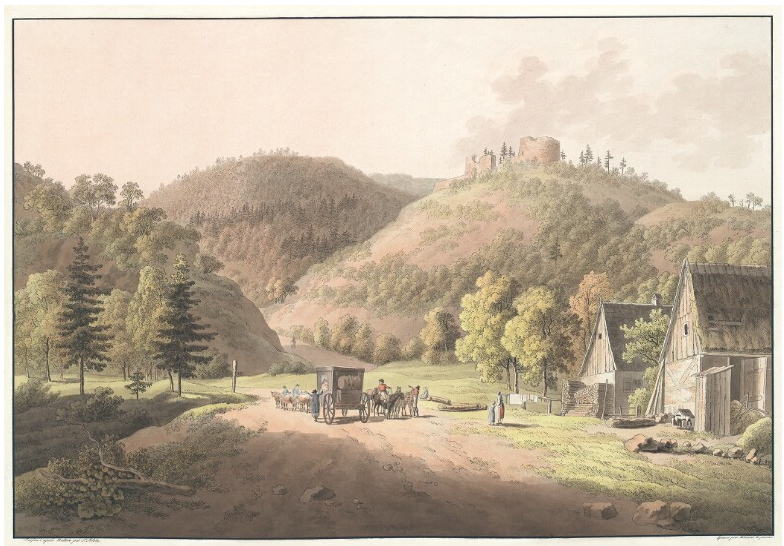
Figure 41. Simon Petrus Klotz after Johann Friedrich Wizani. Geyersberg near Töplitz in Bohemia , early 1820s.